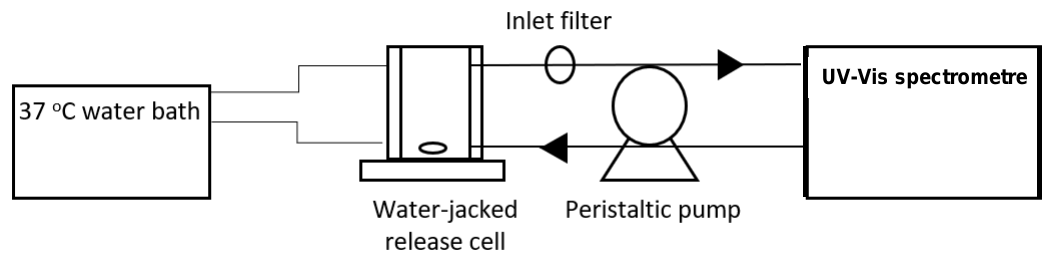
Figure 1. Schematic of the experimental set-up release apparatus.